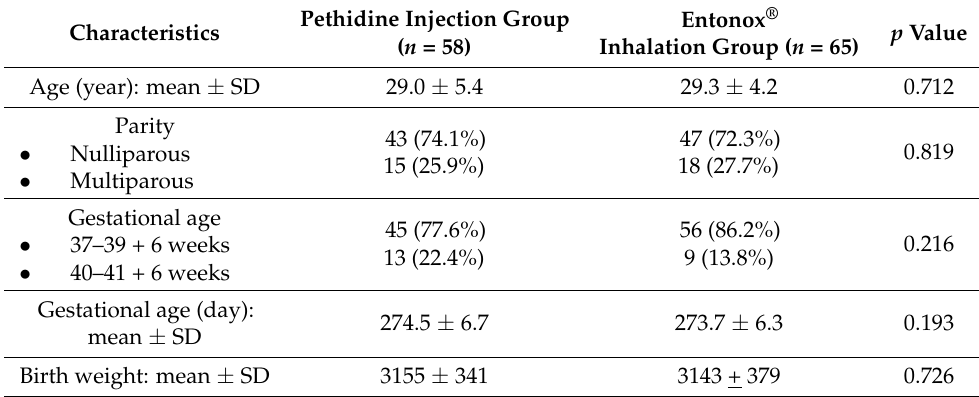
Figure 1. Flow diagram showing enrollment and randomization of the study. Table 1. Comparisons of baseline maternal characteristics between pethidine injection group and Entonox ® inhalation